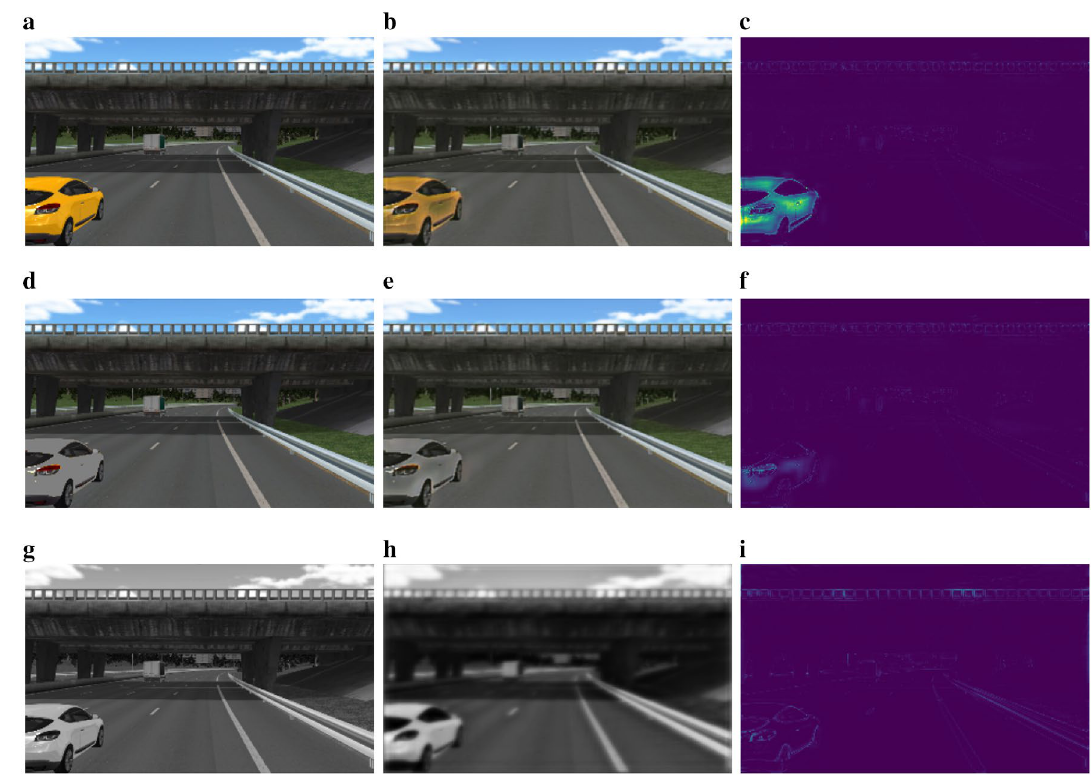
reconstructed image, f modified reconstruction error image, g greyscaled input image, h greyscaled reconstructed image, i grey- scaled reconstruction error